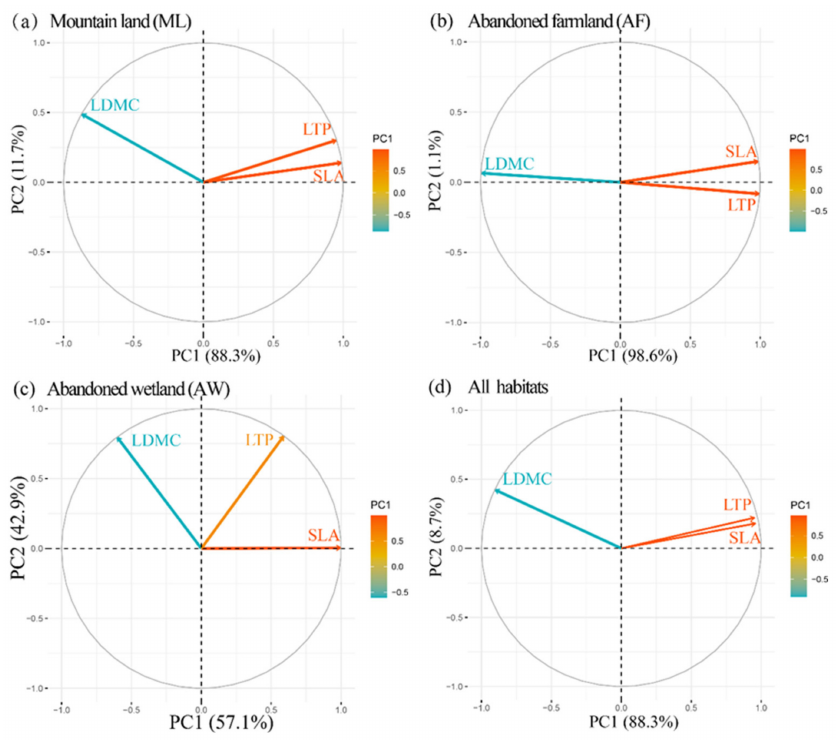
Figure 3. Principal component analysis (PCA) of LES traits of plant communities in different habitat types and overall habitats.